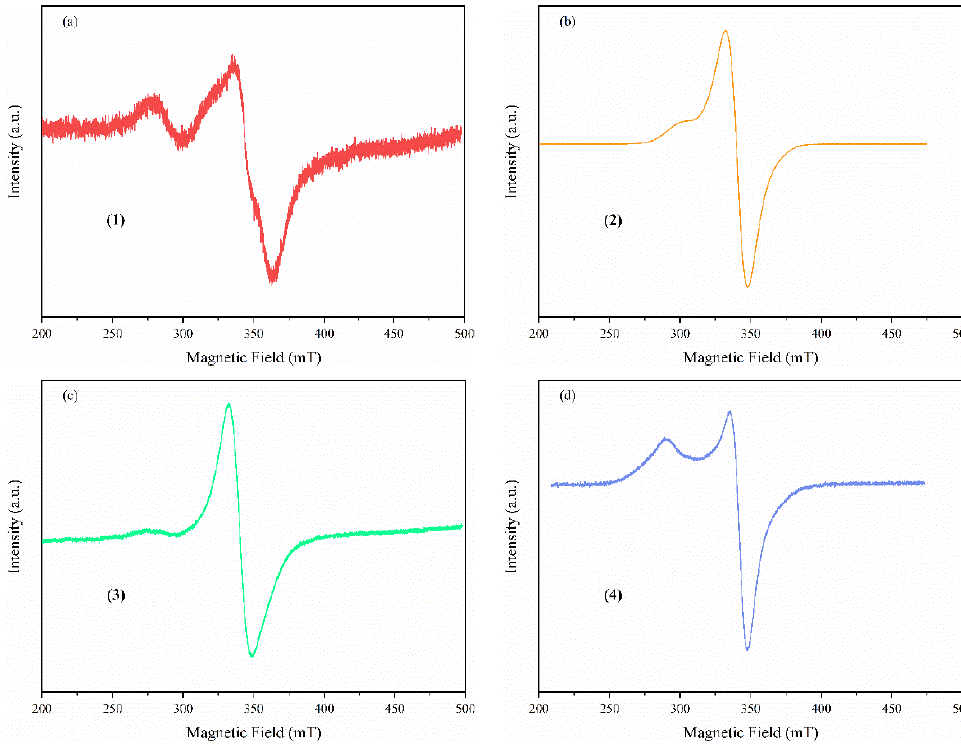
Figure 5 . Powder EPR spectra of the complexes (( 1 )-( a ), ( 2 )-( b ), ( 3 )-( c ), and ( 4 )-( d )). Solution EPR Spectroscopy